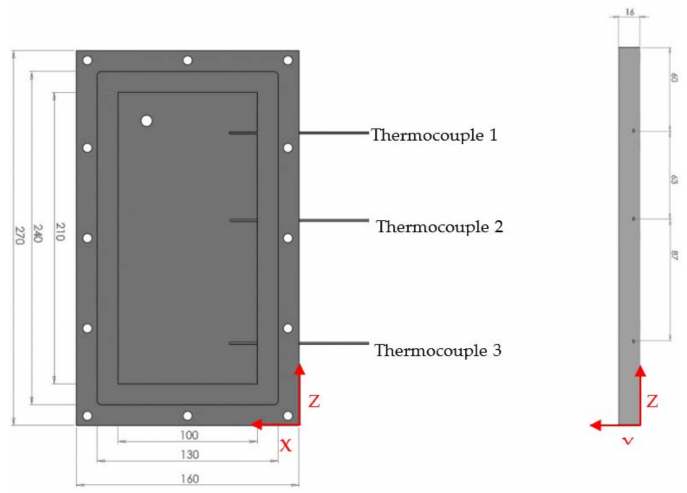
Figure 1. Schematic diagram of the grooved structure of the bottom plate of the semi-visualized plate gravity heat pipe (SVPGHP) (unit: mm).